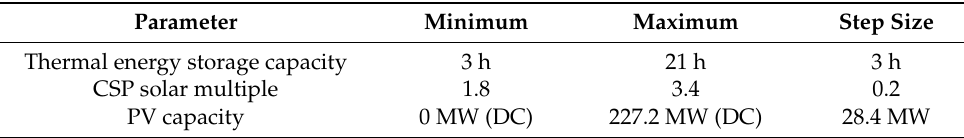
Table 5. Variation of key design parameters to identify optimal